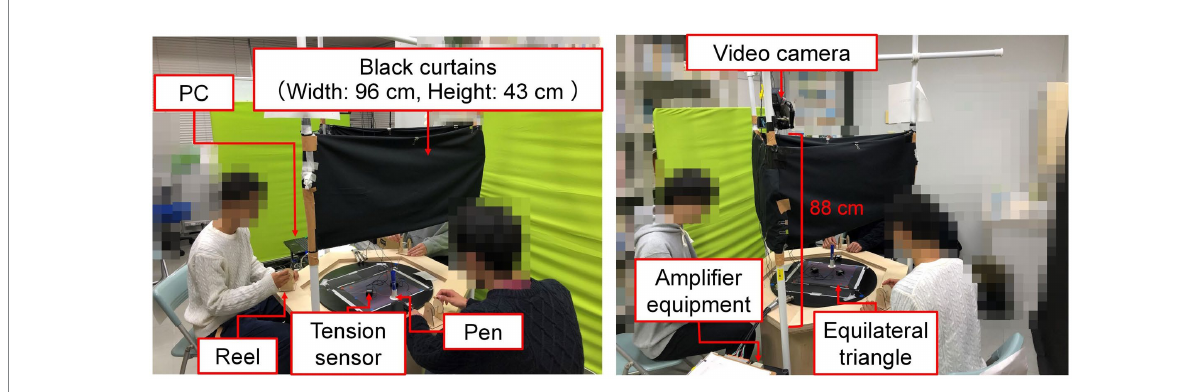
FIGURE 2 Experimental environment. The left image shows the right and left-side participants correspond to operators [1] and [3], and the right image presents the left-side participant corresponds to operator [2] in Figure 1A. According to the informed consent, all the images are shown while blurring some sections to avoid identifying individuals. The origin source of the figure refers to our proceedings paper (Ichikawa and Fujii,